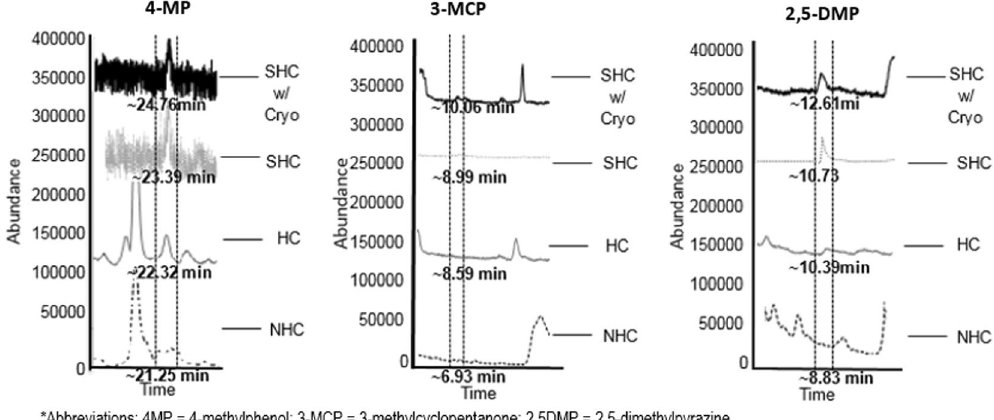
Figure 5. MDGC-MS-O mode for separation and identification of characteristic compounds of lion marking fluid. Separation and enhanced isolation of three characteristic odor-defining compounds extracted from lion marking fluid using four MDGC-MS-O modes: no heart-cut (NHC), heart-cut (HC), Selective Heart-Cut (SHC), and Selective Heart-Cut with Cryotrap (SHC w/Cryo).